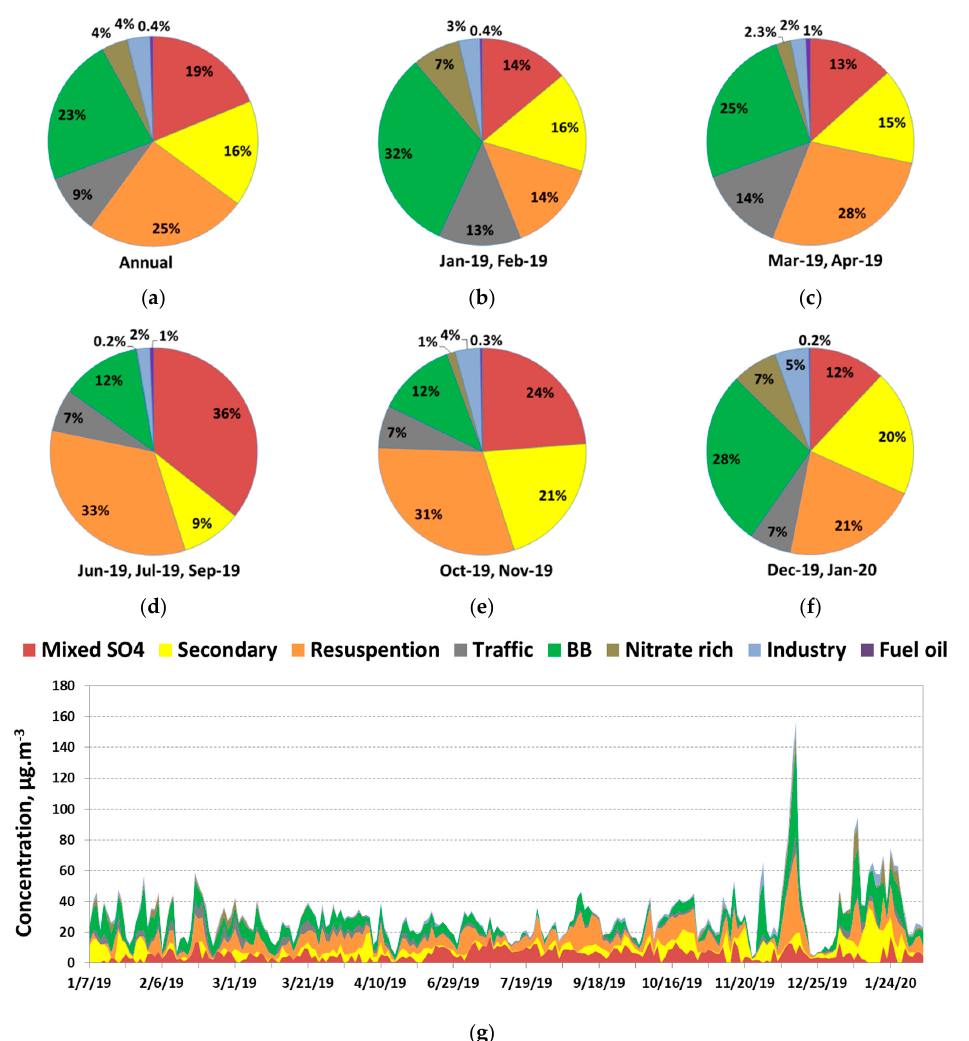
Figure 6. Source profiles (%) on annual ( a ) and seasonal bases ( b ) Jan and Feb 2019; ( c ) Mar and Apr 2019; ( d ) Jun, Jul and Sep 2019; (e) Oct and Nov 2019; ( f ) Dec 2019 and Jan 2020), and daily source contributions to PM10 ( g ).